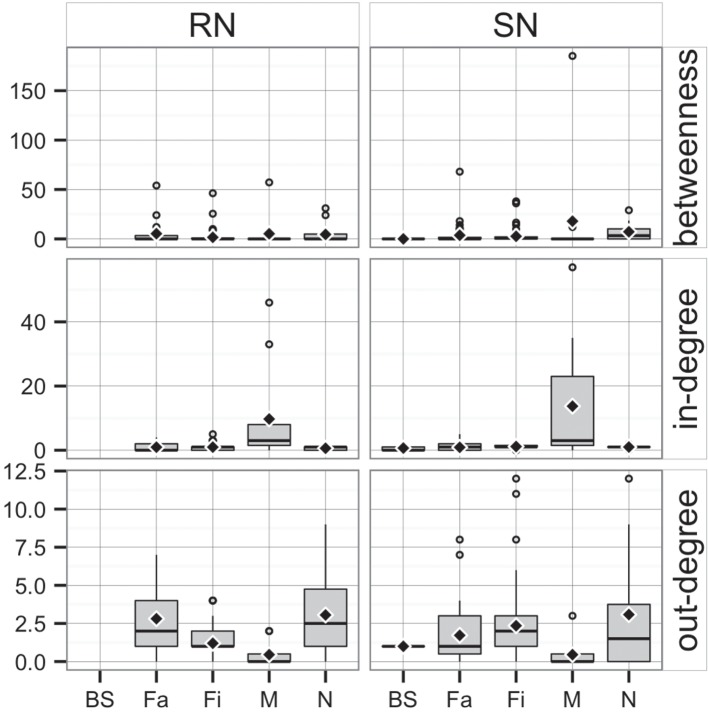
Boxplot of betweenness, in- and out-degree in Rice network and Stevens network by production type (BS, boar stud; Fa, farrowing; N, nursery; Fi, finishing; M, market sites). Boxes indicate the first and third percentile; middle bars represent the median and diamonds represent the mean.